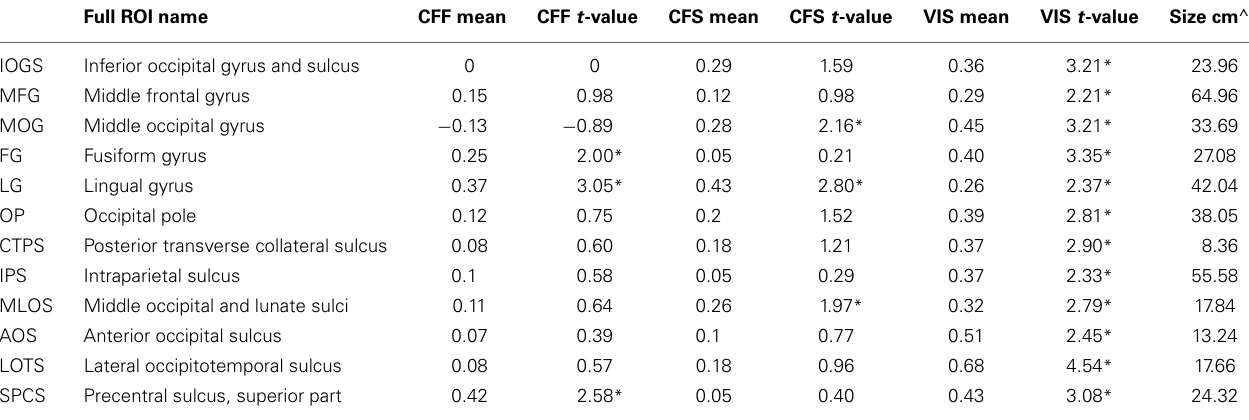
Table 1 | ROI names, t -values, and mean accuracies for all significant within-method classifications, * Indicates FDR-corrected p < 0 .